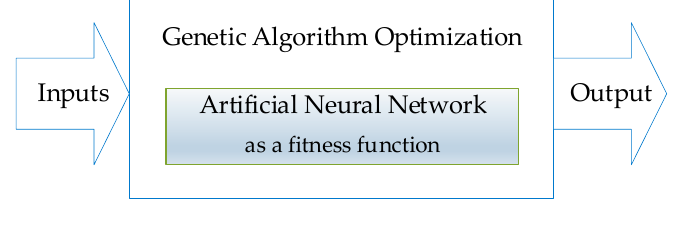
Figure 17. Neural-genetic controller.